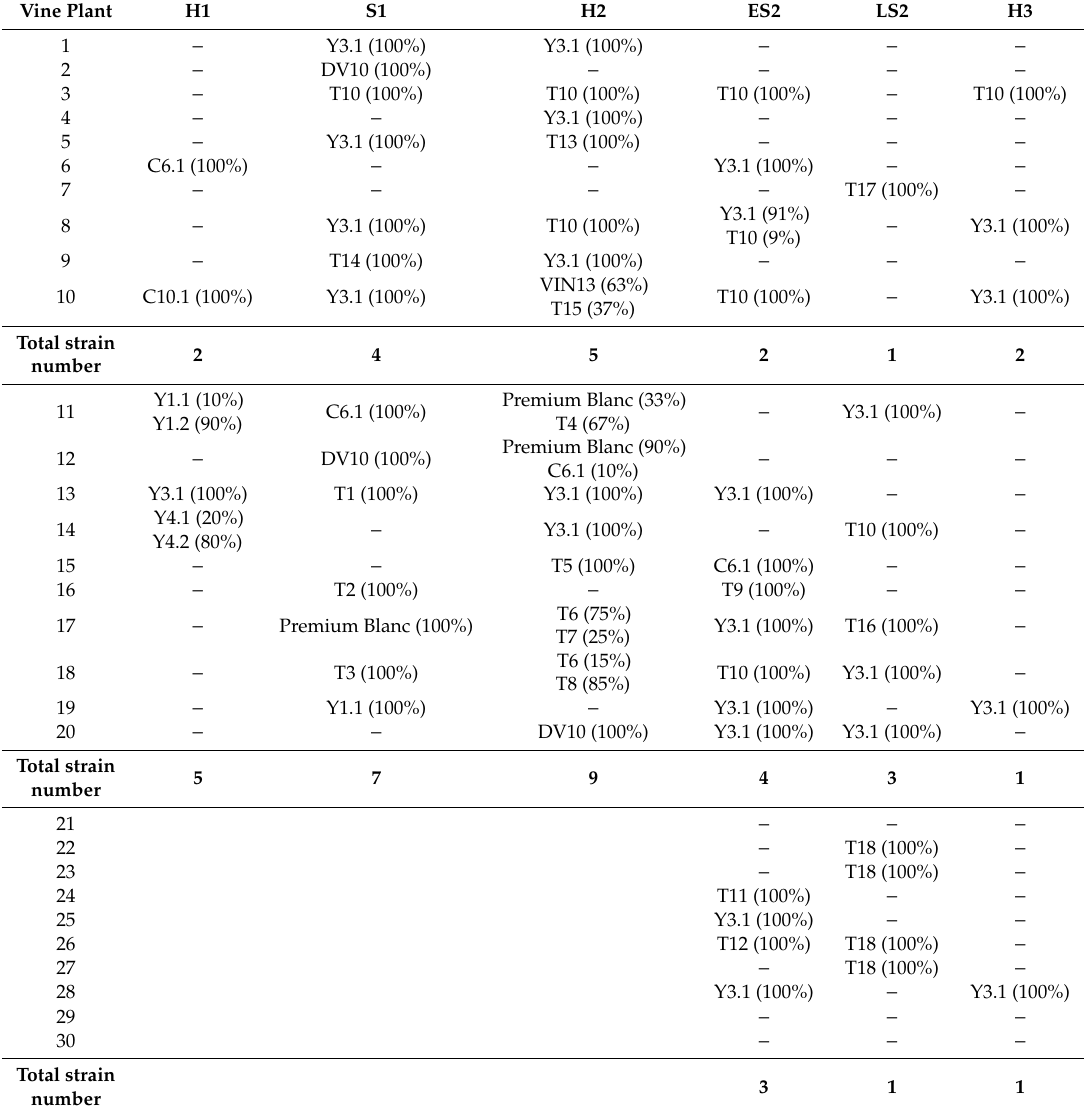
Table 1. Presence of Saccharomyces cerevisiae ( S. cerevisiae ) strains in bark samples collected from 30 vine plants (three rows) in the OV. Plants 2–30 were sampled only at early spring 2 (ES2), late spring 2 (LS2), and harvest time 3